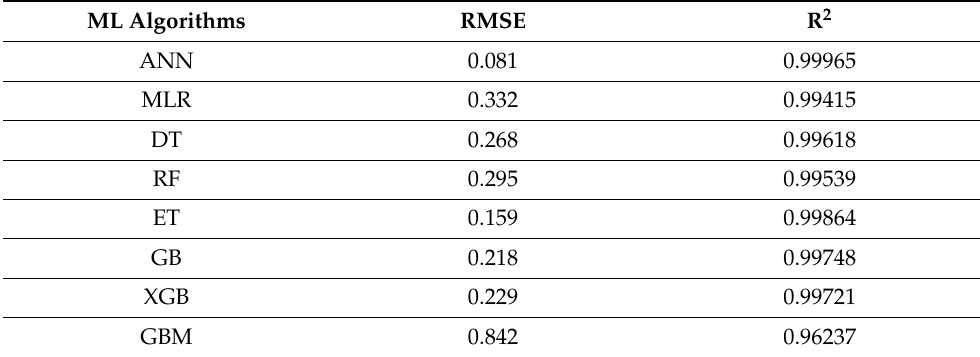
Table 3. Prediction performance of predictive models.